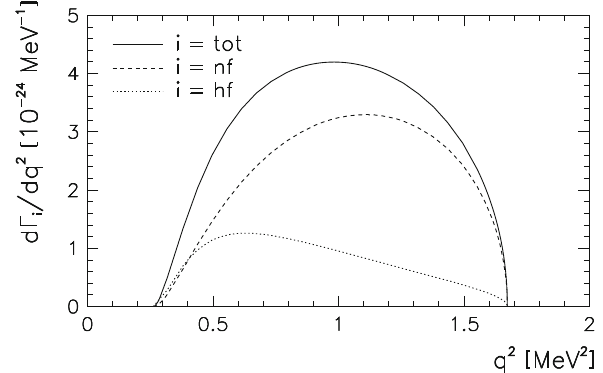
Fig. 3 q 2 dependence of the longitudinal polarisation P (cid:3) e ( q 2 ) for two different sets of form factors (solid and dashed lines). The straight lines represent the longitudinal polarisation integrated over q 2 ∈ [ m 2 (cid:3) ,( M n − M p ) 2 ]